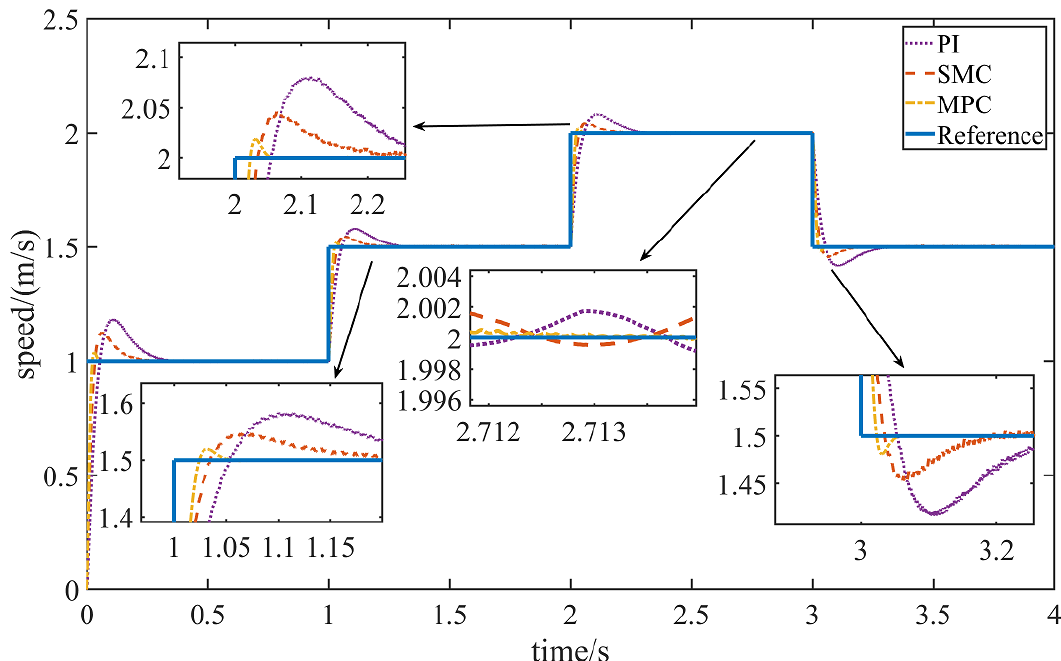
Figure 6. Comparison of variable-speed motion.